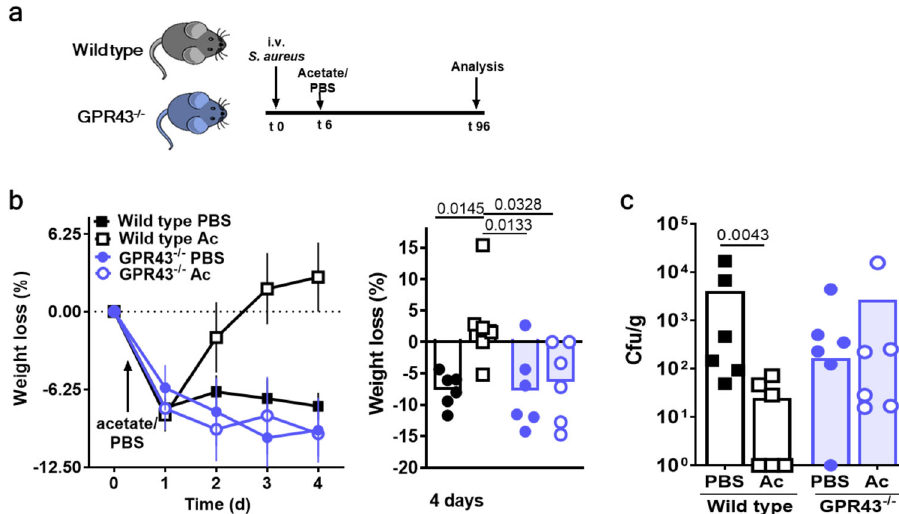
Fig. 7 Acetate treatment after infection onset improves sepsis outcome. a Mice were treated with acetate (Ac) in PBS or an equal volume of PBS 6 h after the onset of an S. aureus bloodstream infection, and septic wild-type (black symbols) and GPR43 − / − (blue symbols) mice were monitored for 4 days. b Acetate-treated wild-type mice regained weight more rapidly than PBS-treated wild-type mice. c This was accompanied by a reduced bacterial load in the liver when compared to PBS-treated septic mice. GPR43 − / − mice displayed similar bacterial loads in the liver compared to PBS-treated wild-type mice ( c ). Acetate (Ac) treatment showed no effect in GPR43 − / − mice. Data in panels b , c represent geometric means or geometric means ± SEM ( b ) from six animals. * P < 0.05; **P < 0.01 signi fi cant difference versus the indicated condition as calculated by one-way ANOVA with Dunnett ’ s multiple comparisons test ( b ) or by Mann – Whitney U test ( c